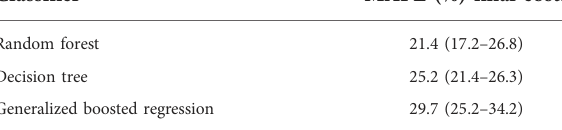
TABLE 4 Internal validation performance for the three developed